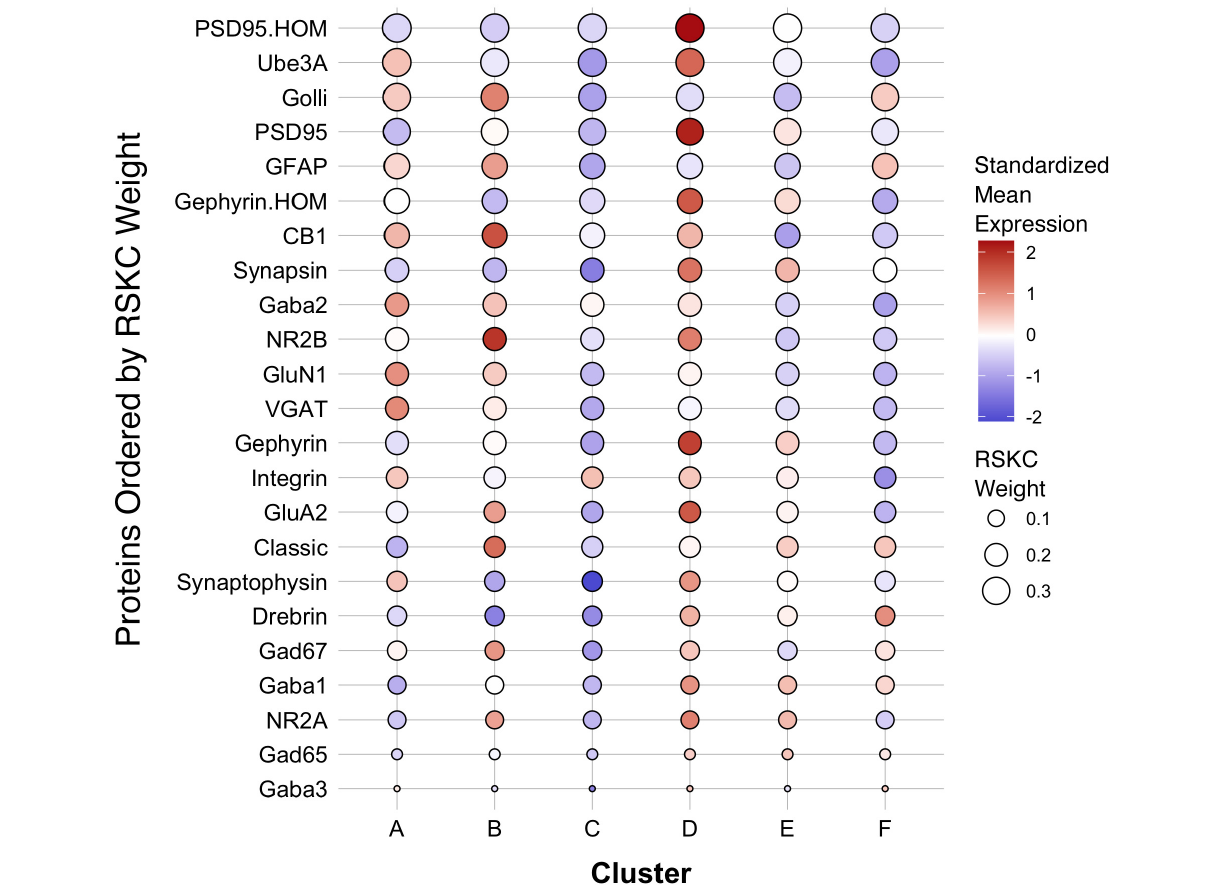
those proteins are essential molecular components that